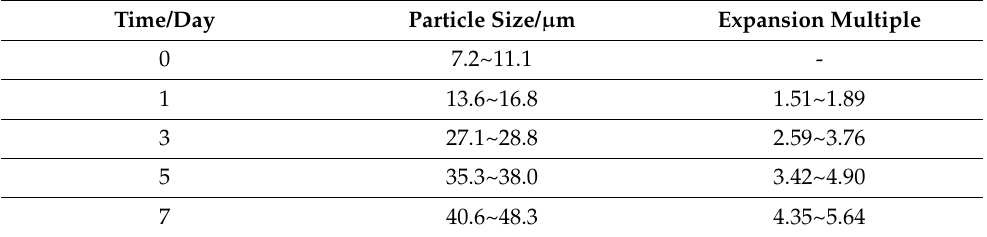
Table 4. Relationship between polymer microsphere particle size and hydration time.